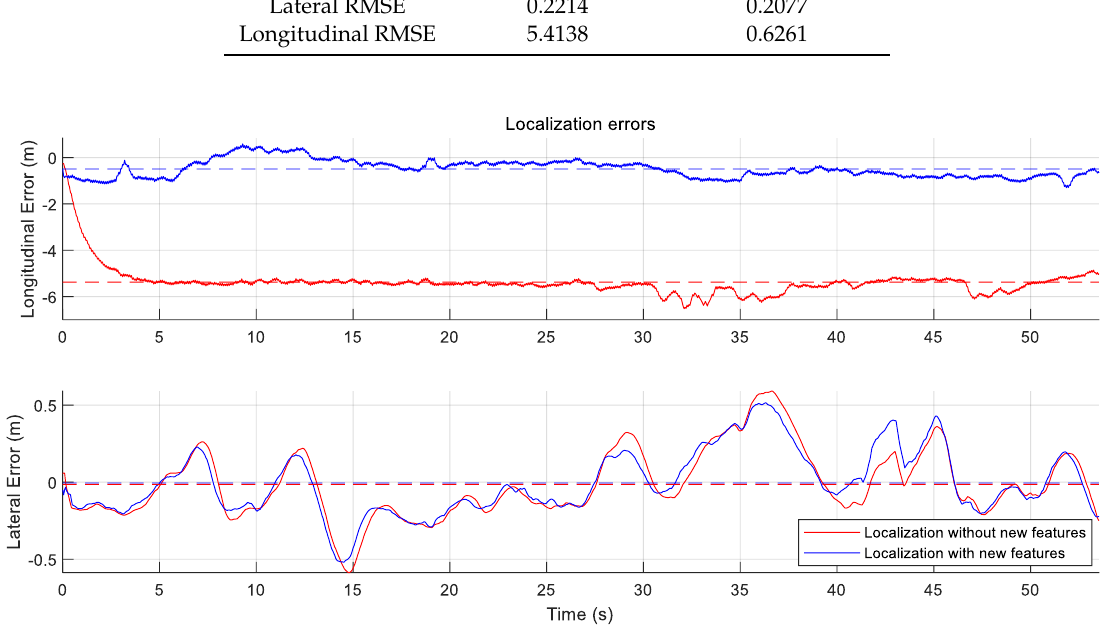
Figure 12. Localization errors. (top) the error to the longitudinal direction and (bottom) the error to the lateral direction. The longitudinal errors based on the localization with the new feature layer is more reduced than the errors based on the localization without the new feature